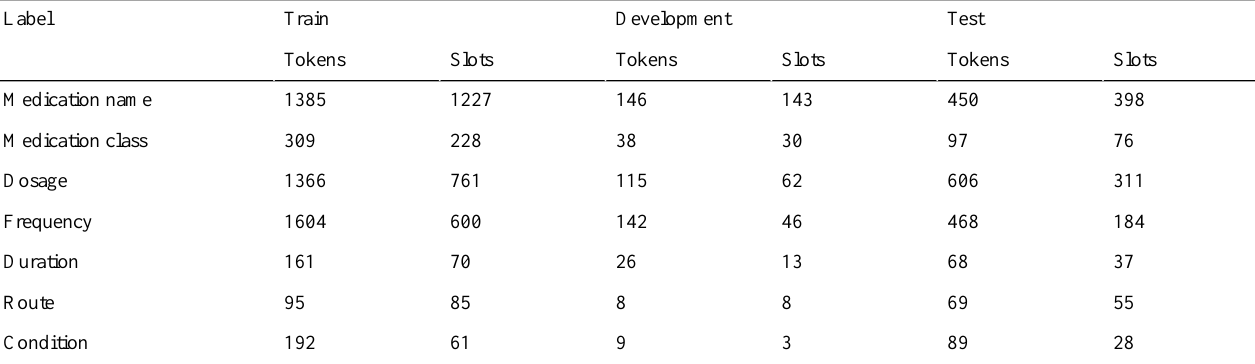
Table 2. Number of slots and tokens for each class per data set. TestDevelopmentTrainLabel